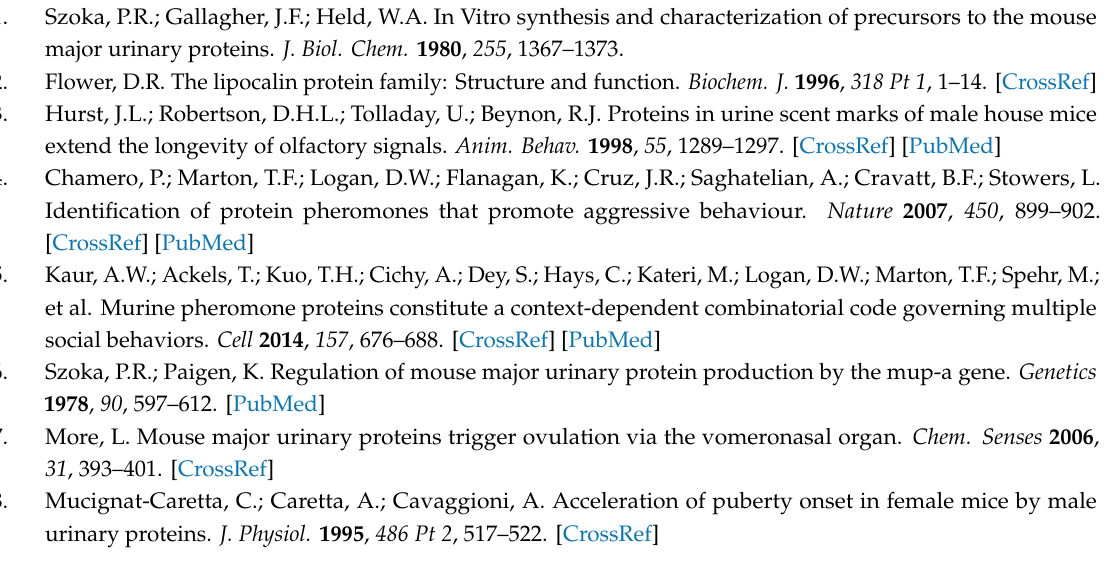
Figure S1: real-time RT PCR results for Igf1 and Zhx2 mRNA levels in livers of mice fed (a) or injected intraperitoneally (b) with resveratrol (RSV) compared to ad-libitum control mice (CON) and mice under dietary restriction